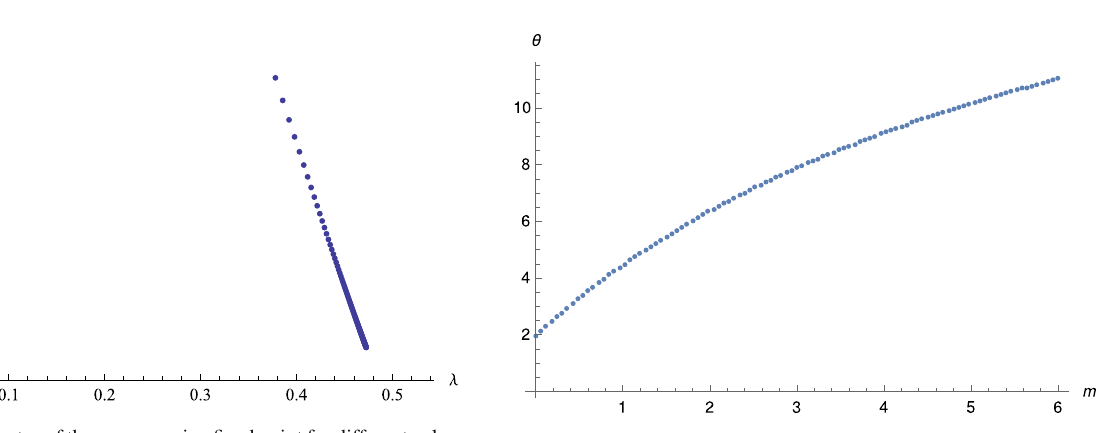
= 0 , 0 . 1 and 0 . 5. Here λ k